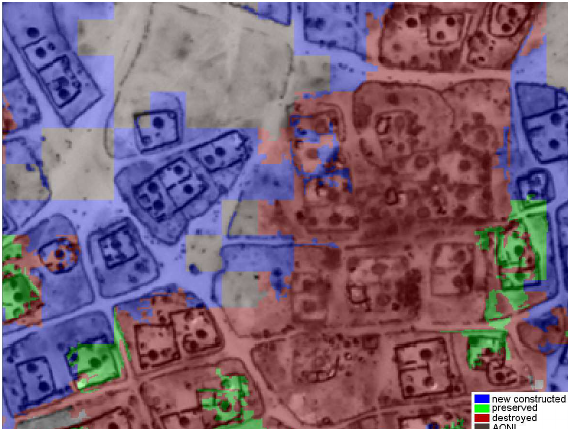
Figure 5. Results in detail of the Change Detection Analysis for the village Abu Suruj.